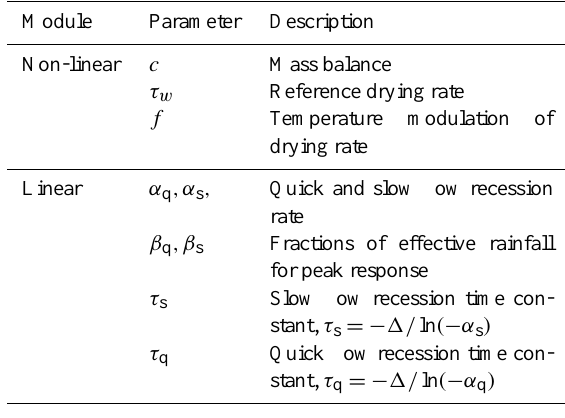
Table A1. Parameters in the IHACRES